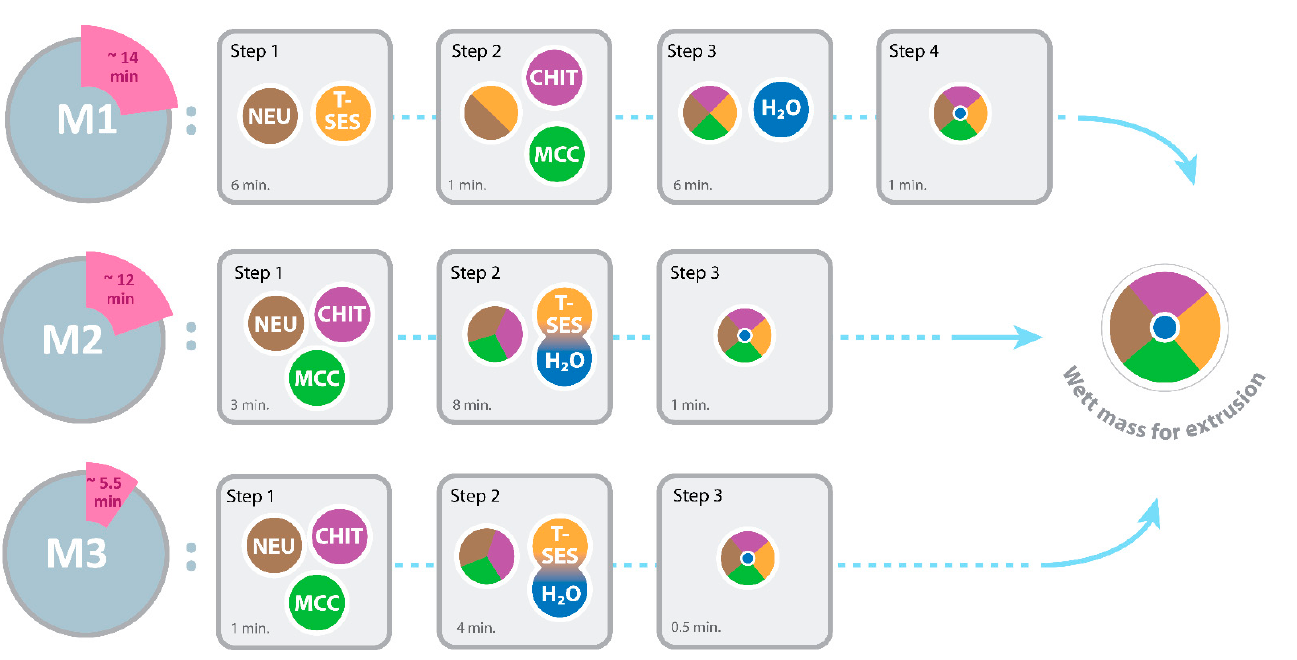
Scheme 2. Graphical representation and timeline of the three different preparation procedures (M1, M2, and M3) of uncoated pellet samples. The duration of individual steps, as well as the duration of the whole process (cumulative time), are